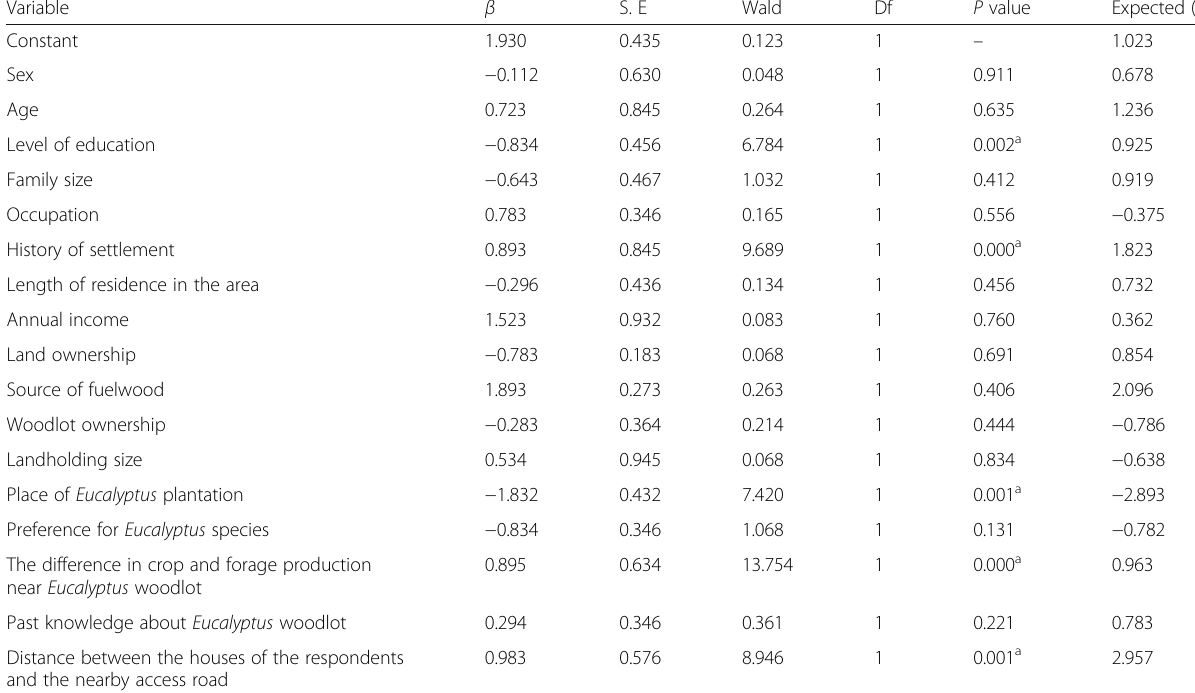
Table 5 Factors affecting local people ’ s knowledge on the adverse impacts of Eucalyptus woodlot in Gudo Beret Kebele Variable β S. E Df